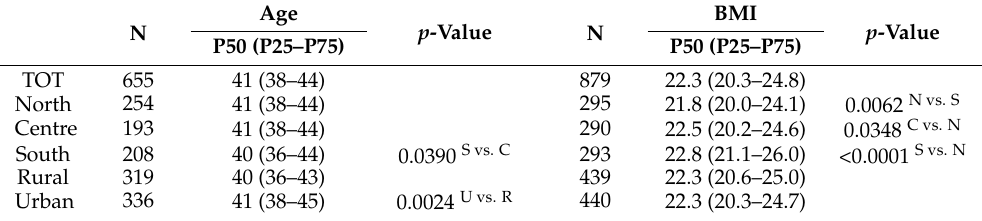
Table 1. Distribution of enrolled women age and BMI in Italian macro-areas and areas. Median values and interquartile range are indicated; p -values for significant differences among groups are indicated in the beside column.